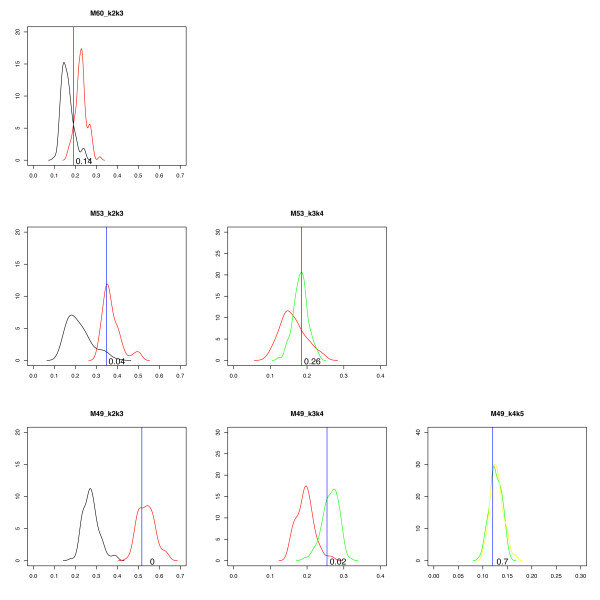
Classifier. Here we show three examples of classification of real samples. From top to bottom, the three samples are classified as 2, 3, and 4 subpopulations, respectively. Each subplot shows two empirical distributions and a blue line representing the NLSK of the query sample. In the first column, the black curve is the smoothed empirical distribution (SED) of NLSb22 (simulated as two subpopulations and fitted as two) and the red curve is the SED of NLSb32 (simulated as three and fitted as two). In the second column, the red curve is the SED of NLSb33 (simulated as three and fitted as three) and the green curve is the SED of NLSb43 (simulated as four and fitted as three). Finally, in the last column, the green curve is the SED of NLSb44 (simulated as four and fitted as four) and the yellow curve is the SED of NLSb54 (simulated as five and fitted as four). The number in the subplots shows how many samples (in %) in the left distribution that obtain a value greater than the value indicated by the blue line.